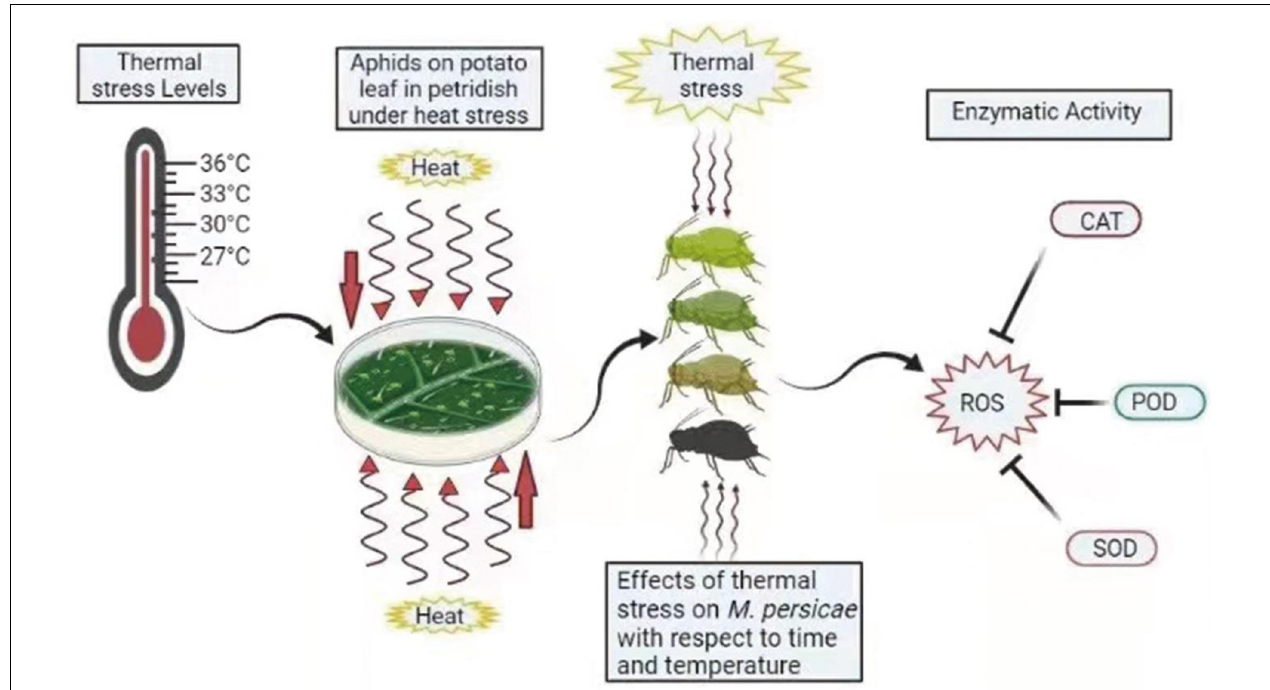
FIGURE 5 | Summary diagram of antioxidant enzymes in M. persicae under thermal stress. Different colors of aphids indicate the effect of heat stress on aphids. ROS, reactive oxygen species; CAT, catalase; POD, peroxidases; SOD, superoxide dismutase. The zigzag arrows indicate the heat waves affecting